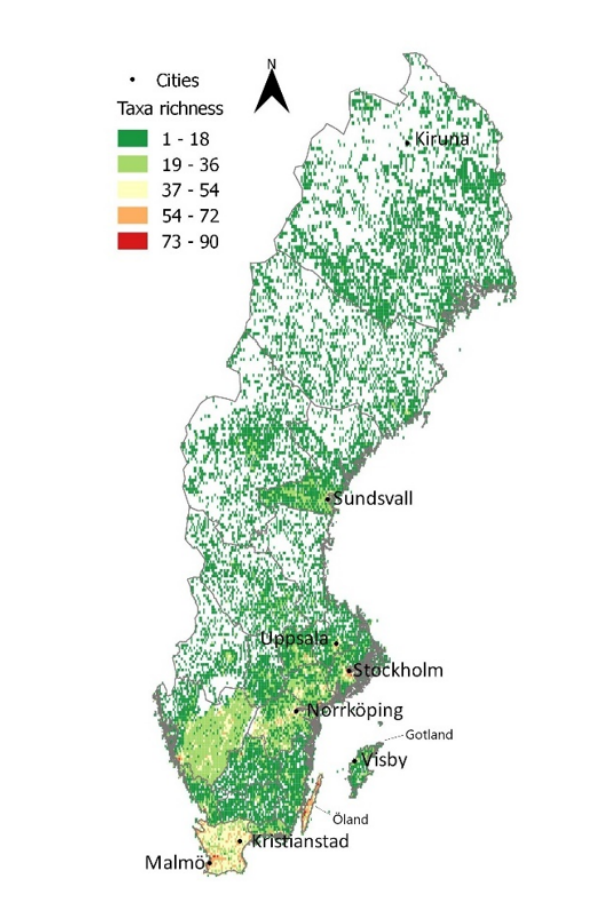
Figure 1. The taxon richness of priority CWR across Sweden. Denmark covering 88 target species in two ELC